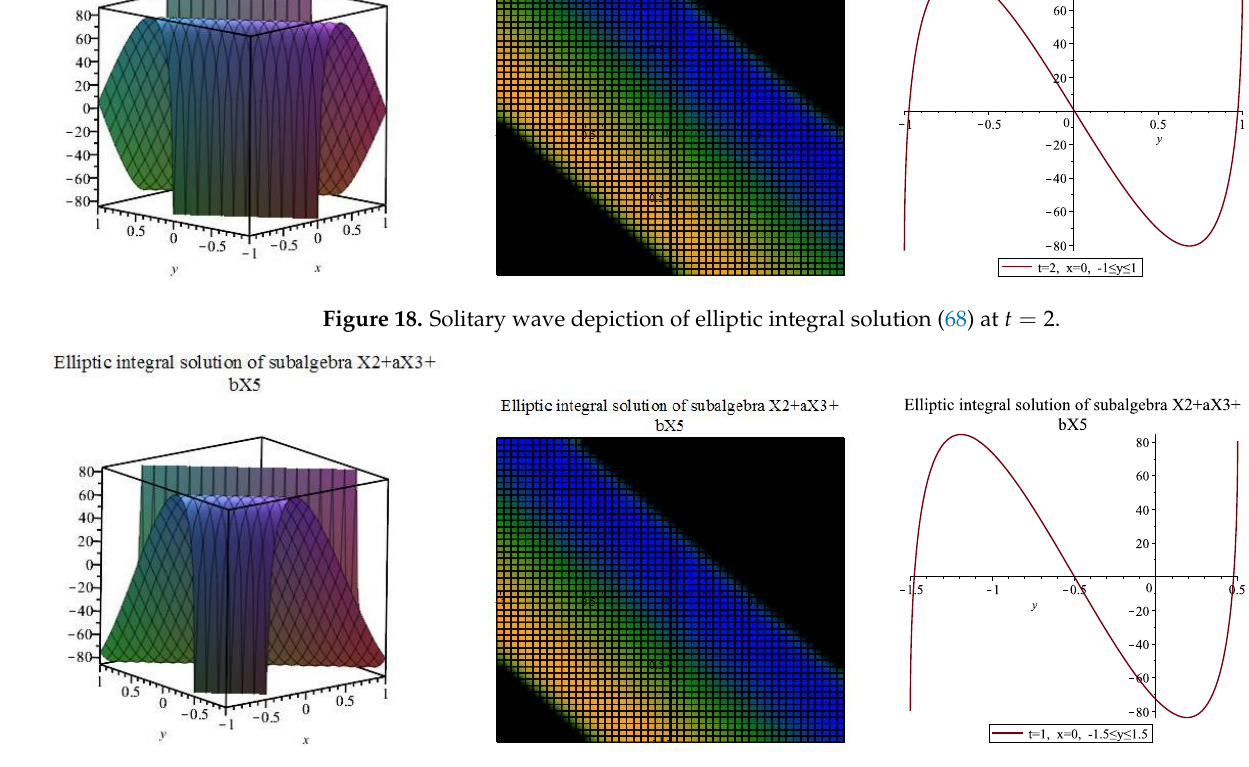
Figure 19. Solitary wave depiction of elliptic integral solution (68) at t =